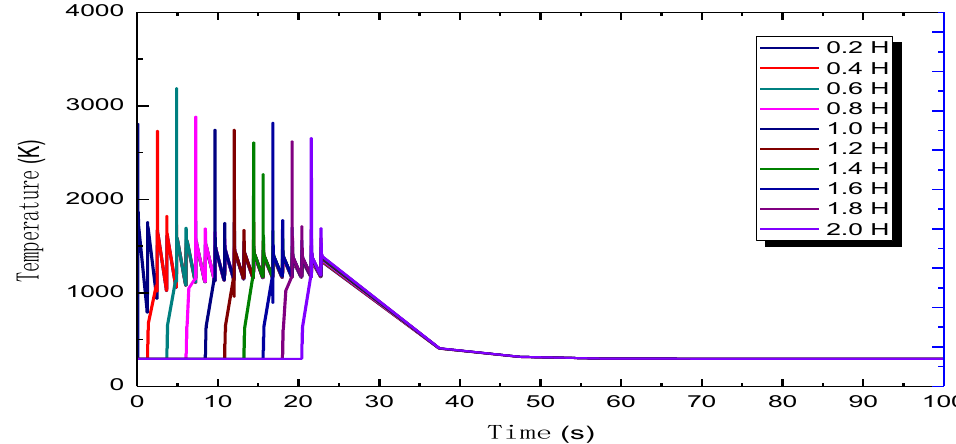
Figure 12. The temperature cycle curve of the numerical simulation at a mid-point in the sample. H is the height of SLM sample in the simulation, the curve is actually the time in X-axis corresponding to the temperature in Y-axis.